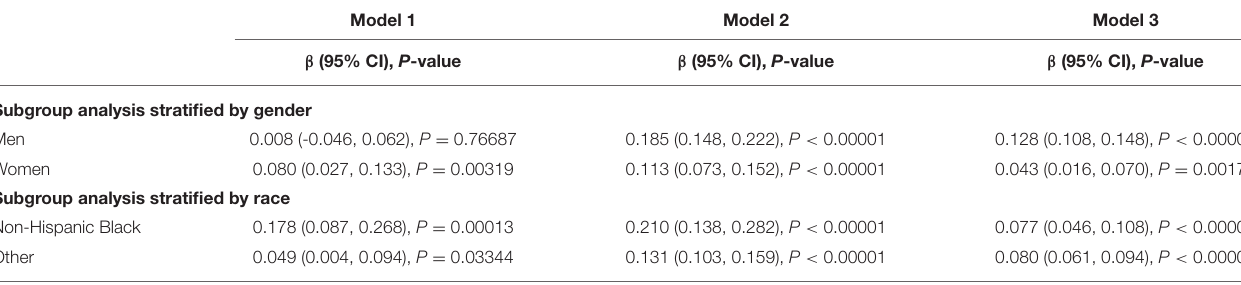
TABLE 3 | Effect size of Remnant-C on 10-year risk of a first hard ASCVD event in subgroup analysis stratified by gender or race.